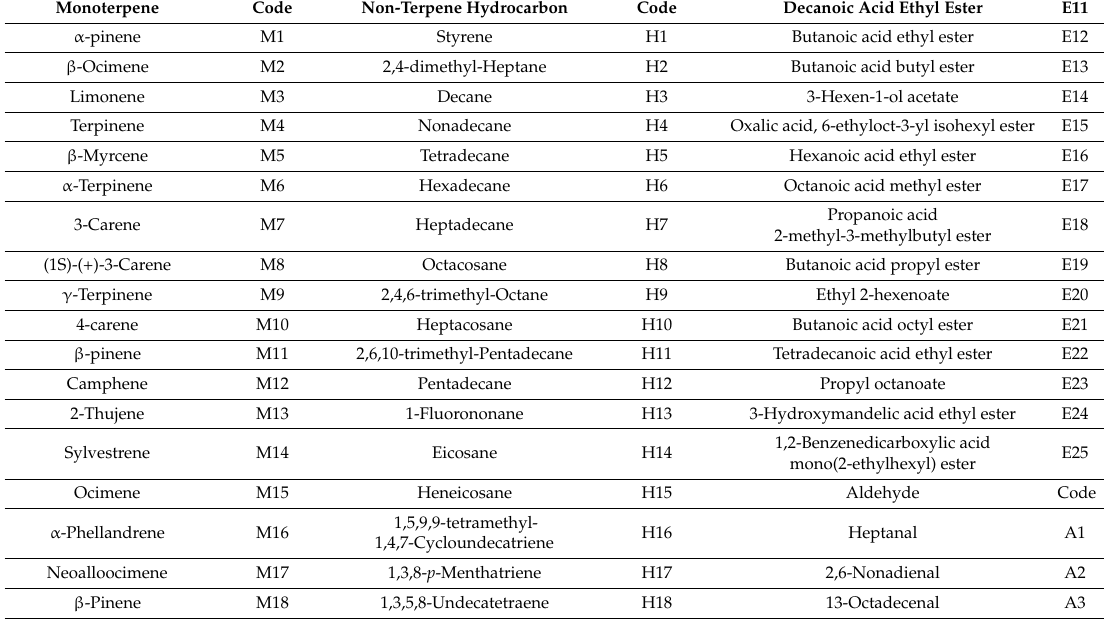
Table 1. Volatiles detected in fruits of all 37